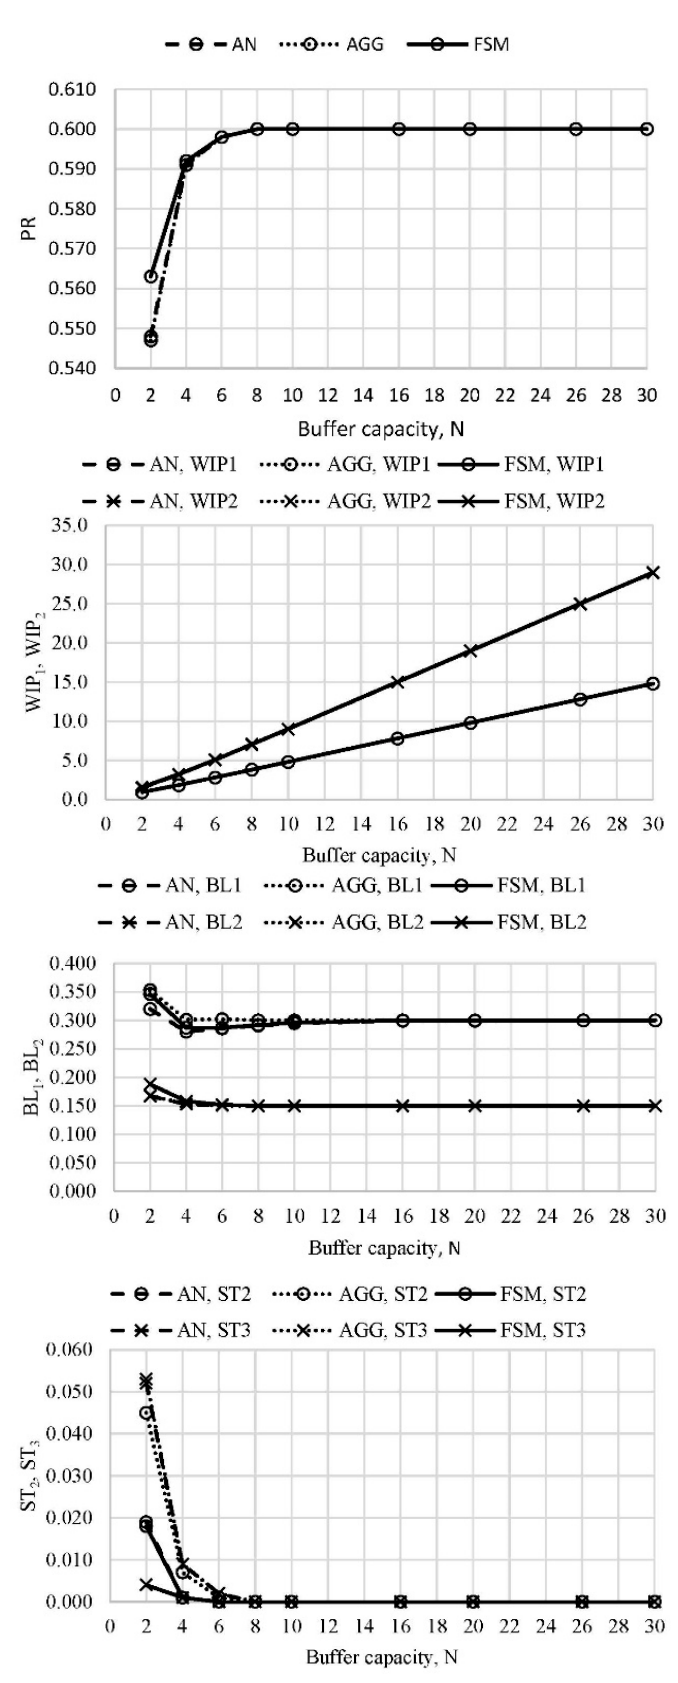
Figure 8. Performance measures of the perturbed line L 2 ′ R ( N 1 = ½ N 2 , N 2 = N ) (authors’ work).